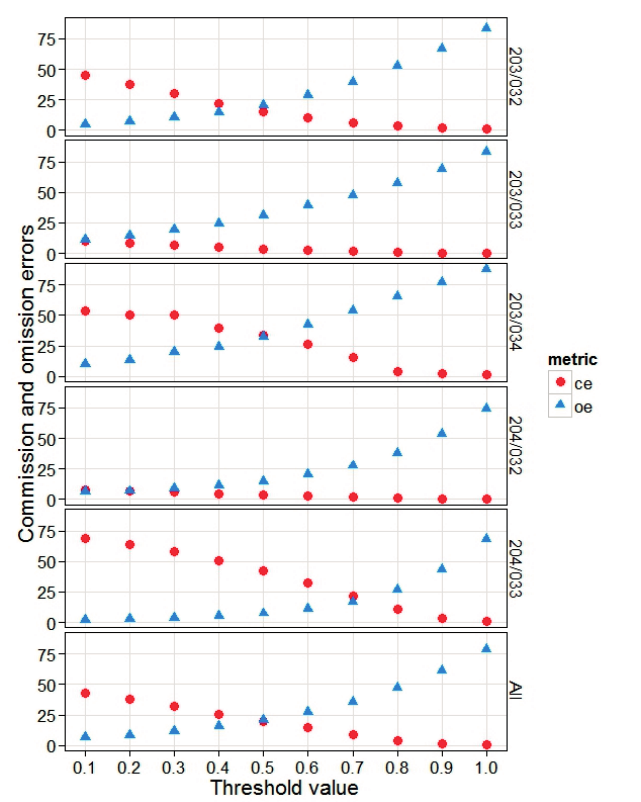
Figure 9. The commission (CE (%), red circle markers) and omission errors (OE (%), blue triangle markers) as a function of the threshold applied to the optical + SAR fuzzy